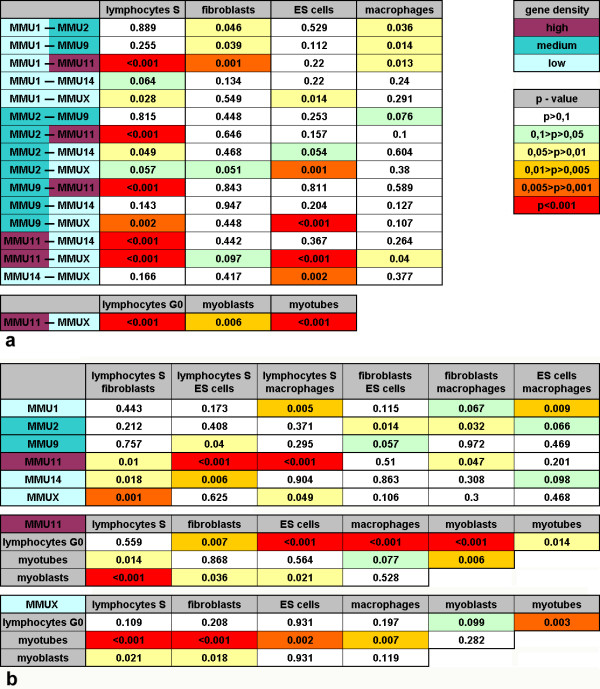
Statistical comparison of relative radial distributions of chromosome territories. Significance levels are shown as p-values from a two-sided Kolmogorov-Smirnov test and are color coded as indicated. Chromosome names are highlighted according to their gene density as indicated. (a) Pair wise comparison of the relative radial distributions of chromosomes in a given cell type. Lymphocytes in S-phase and in G0 are listed separately. (b) Pair wise comparison of the relative radial distributions of a given chromosome territory between cell types.